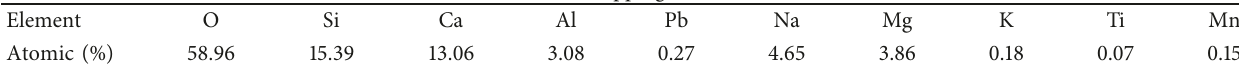
Figure 6: The microstructure of P2 matrix. Table 10: EDS mapping of SR2 matrix.